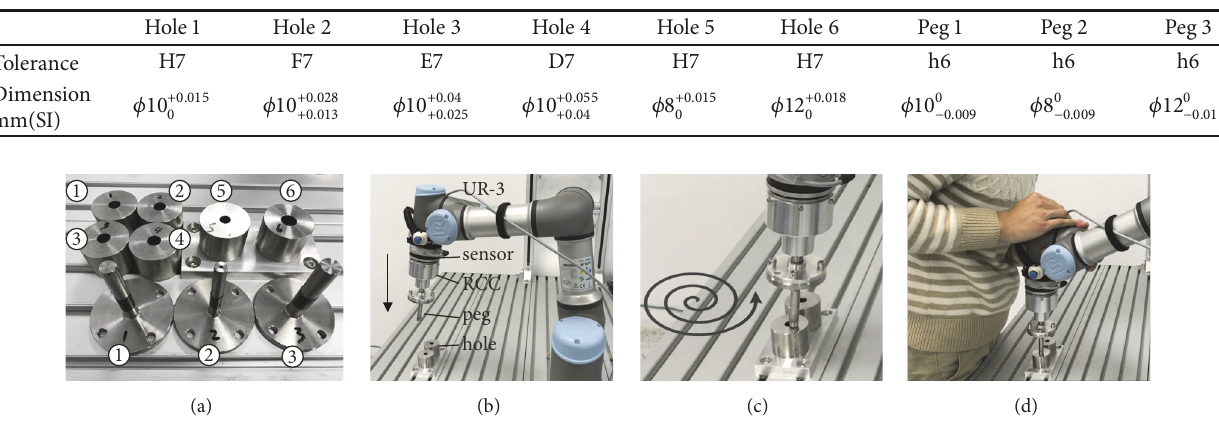
Table 1: Holes and pegs with different fit tolerances and dimensions.